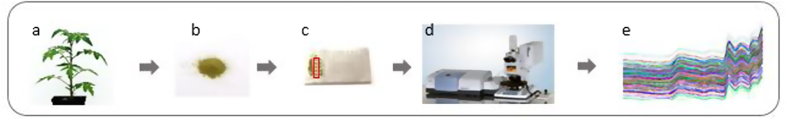
Workflow of the NIRM analysis performed.First step is the reduction of leaf (a) to powder (b) and after this powder is spread into the 96 well plate (c). The plate is then presented to the microscope (d) and 10 NIR spectra are collected at different locations (e).